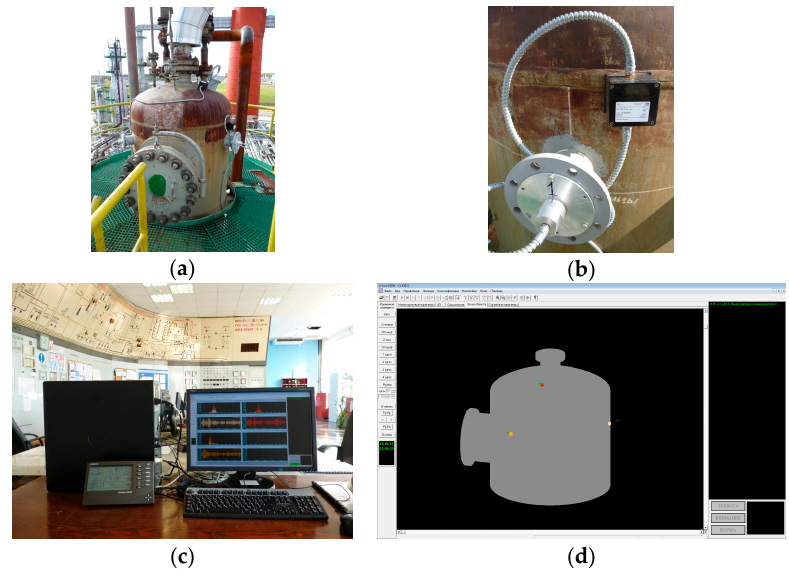
Figure 14. SHM-system for gas adsorber: ( a ) overall view of the head part; ( b ) AE sensor mounting place; ( c ) workplace of operator; ( d ) dialogue box of the software A-Line Mon. Color of points indicates total number of events in this coordinates. Green points: 1–2 events, yellow points: 3–10 events, orange points: 11–25 events, red points: 26–100